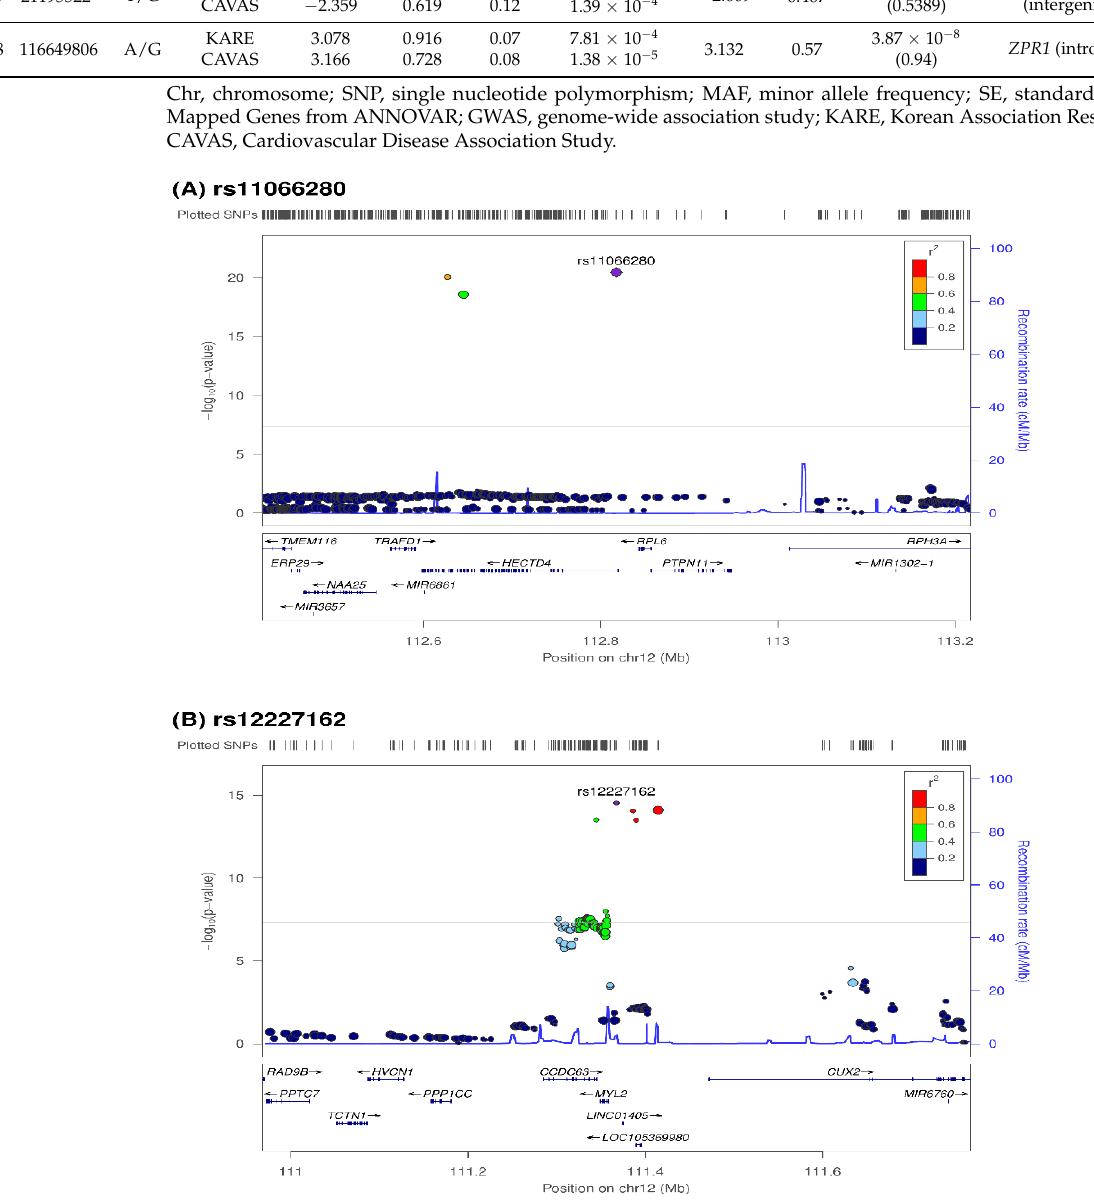
Figure 4. Regional plot of associated SNPs with genome-wide significance.